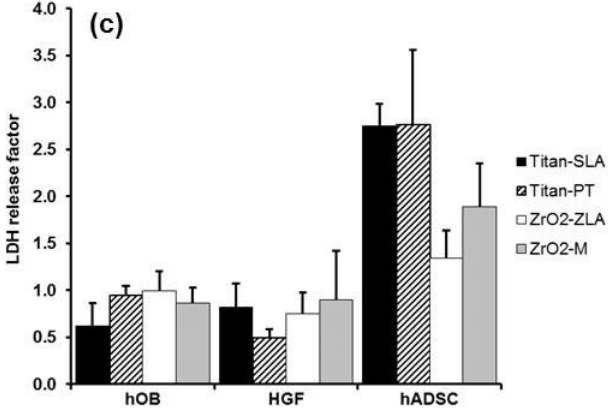
Figure 1. Cell Viability at day 14 correlated to control for human osteoblasts (hOB), human gingival fibroblasts (HGF), and human adipose-derived stromal cells (hADSC) ( a ) cell vitality p = 0.021; ( b ) proliferation rate, p = 0.041, ( c ) LDH release factor, p = 0.0016; standard abbreviation as error marks.